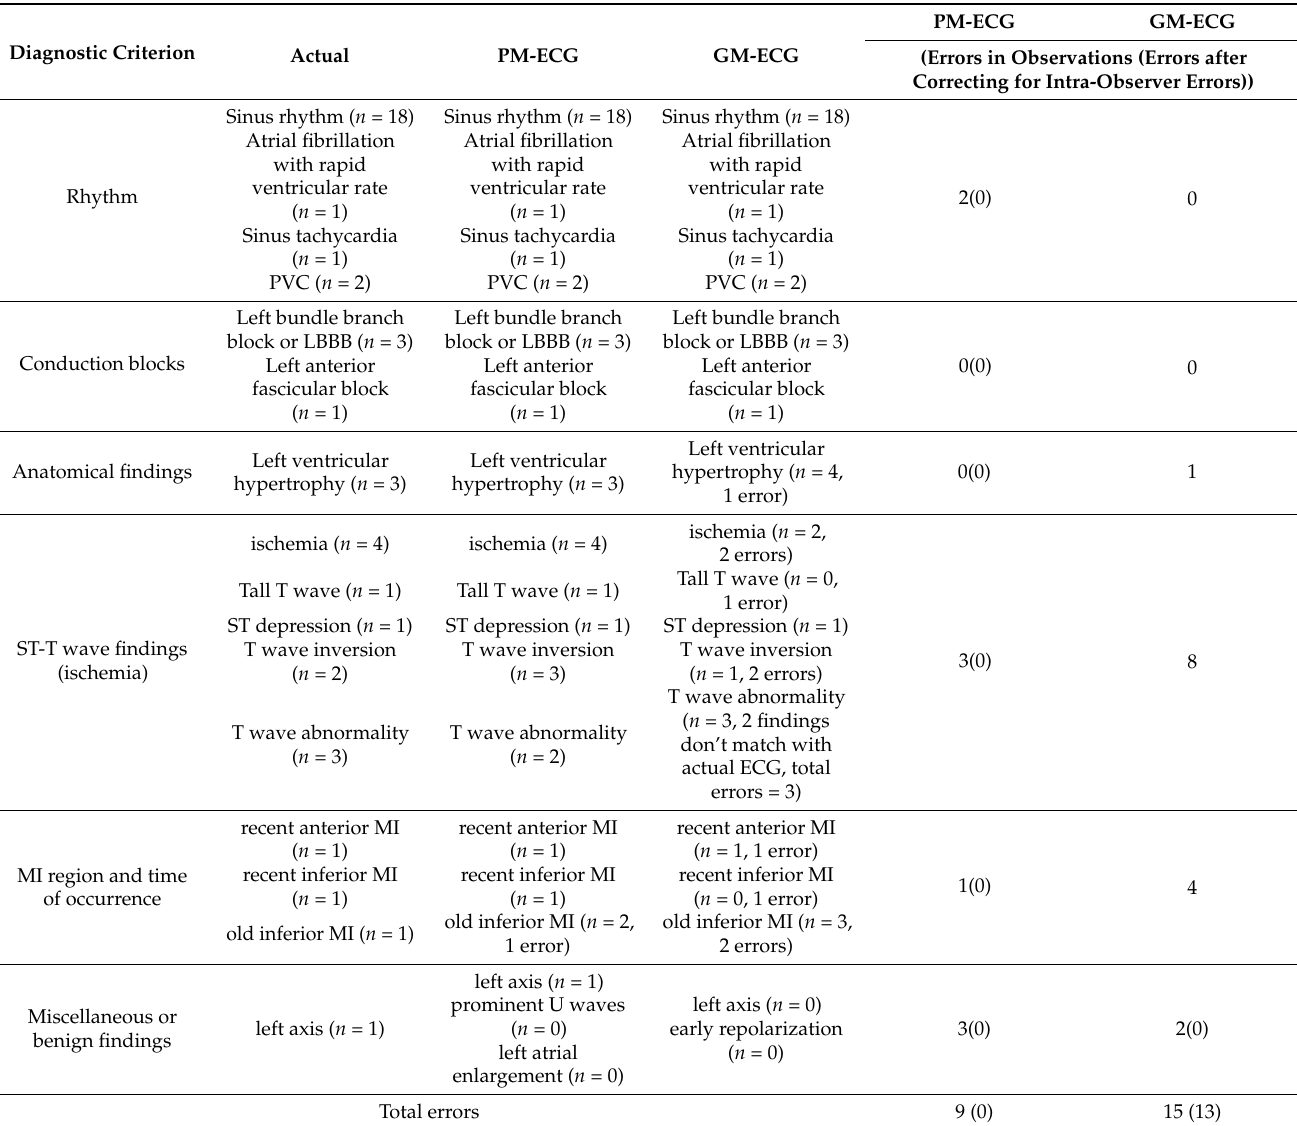
Table 5. Error Rates for ECG interpretation compared to actual ECG with correction for intra- observer